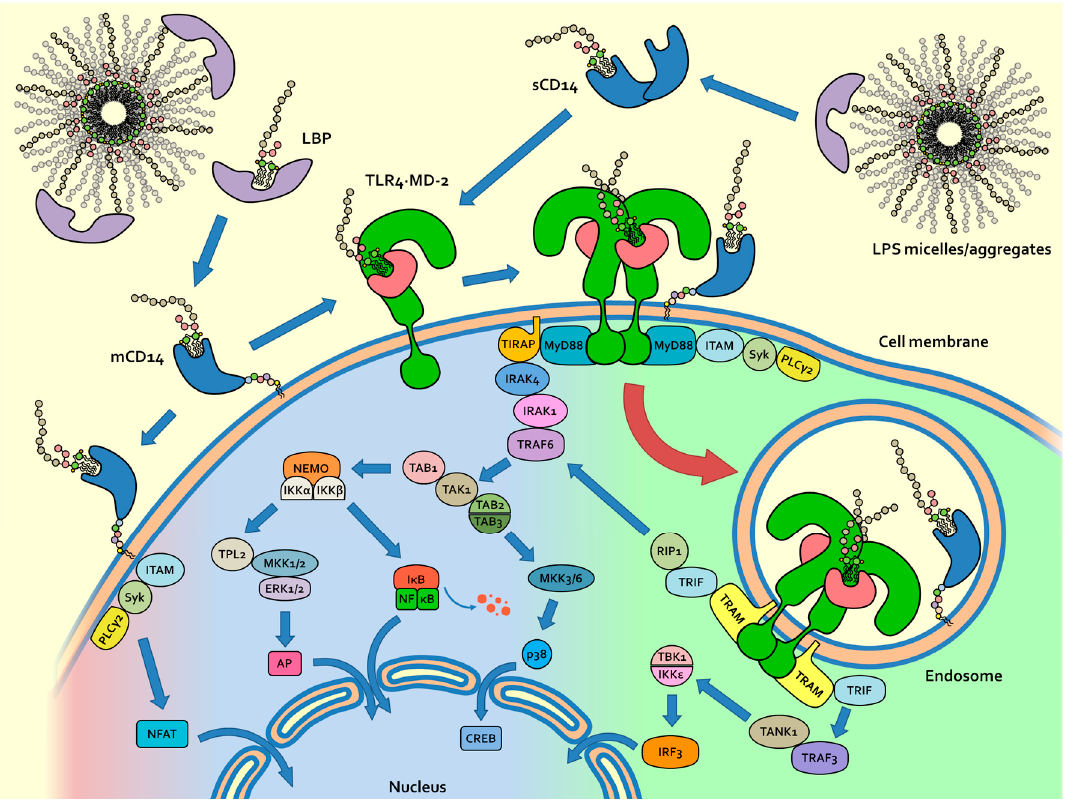
Figure 2. TLR4 activation and signalling from cell membrane and from endosomes: MyD88 and TRIF-dependent pathways are distinct signal pathways leading to cytokine production.